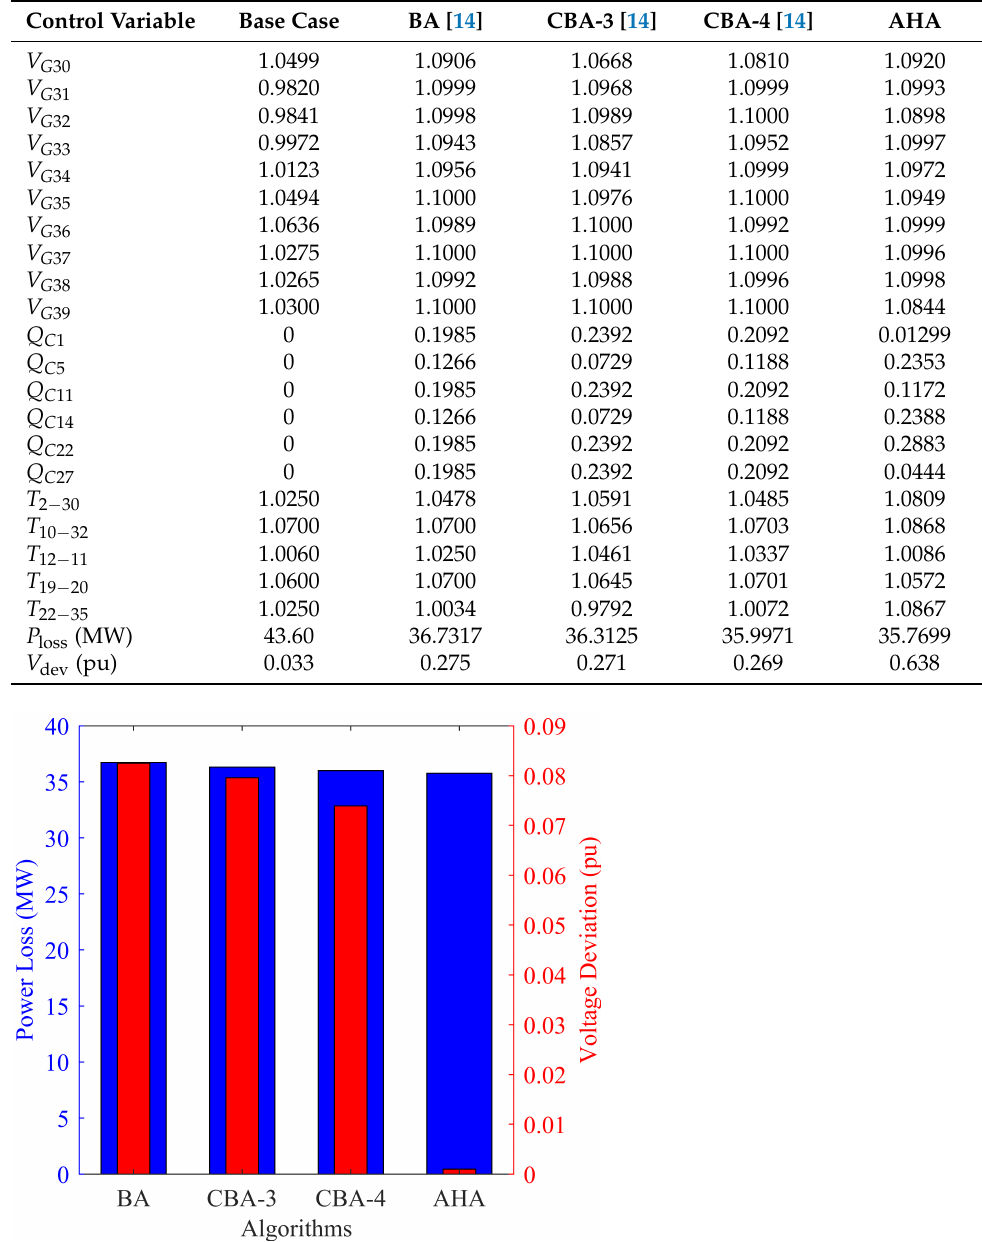
Figure 8. Comparison of P loss and V dev for the IEEE 39 bus test system optimized using the proposed